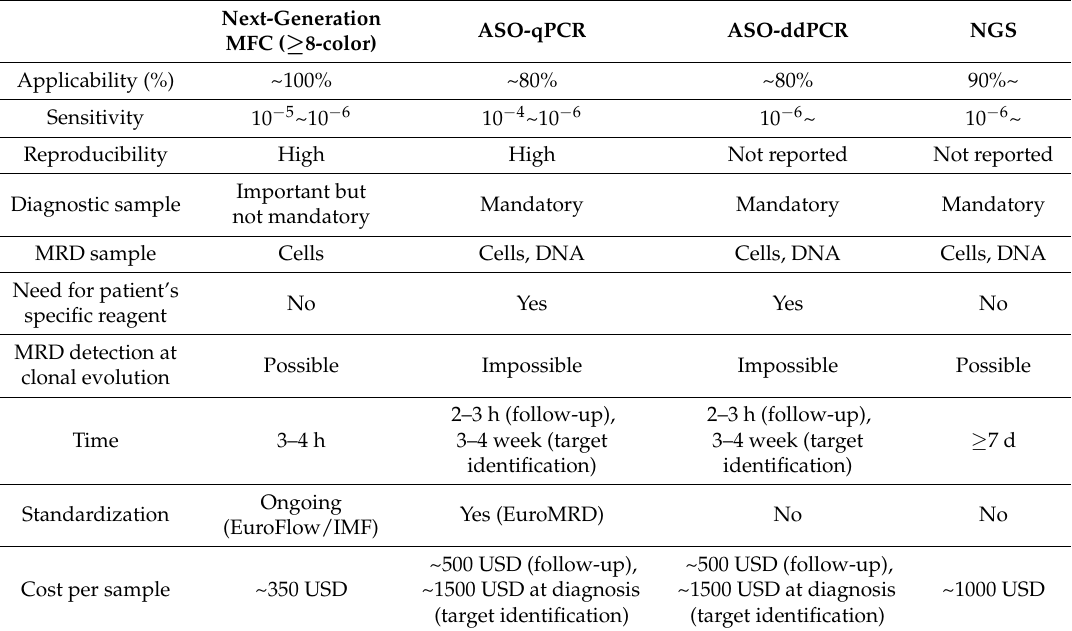
Table 1. Comparison of MRD assays in multiple